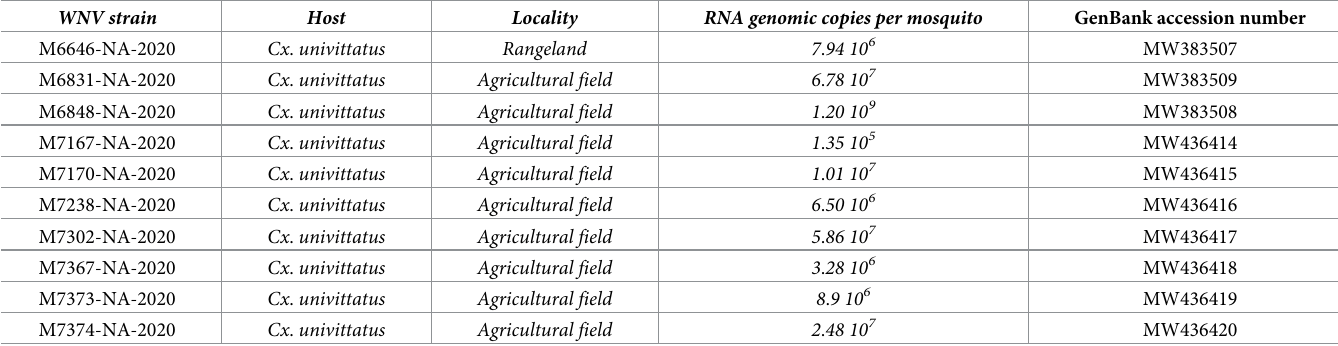
Table 2. WNV strains identified in the Mashi conservancy in this study.